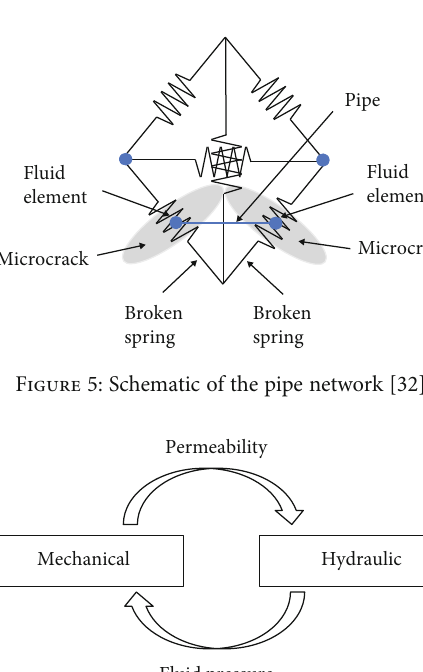
Figure 4: Schematic of a lattice array [37].